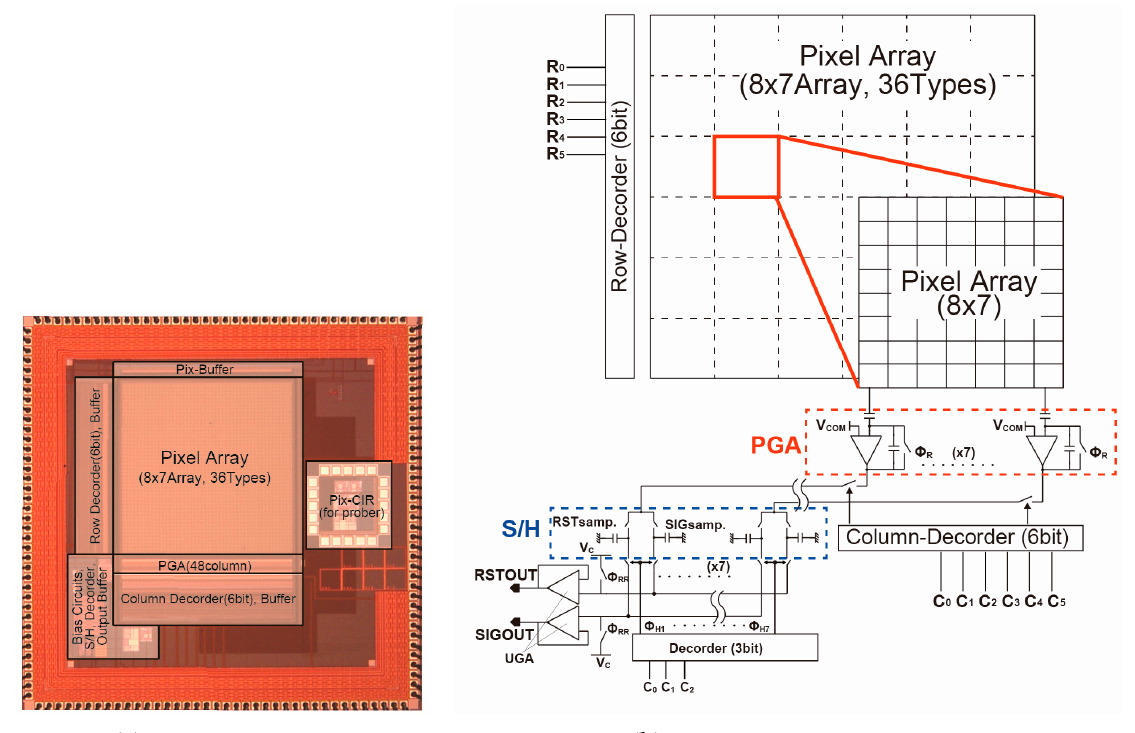
Figure 12. Implemented chip.